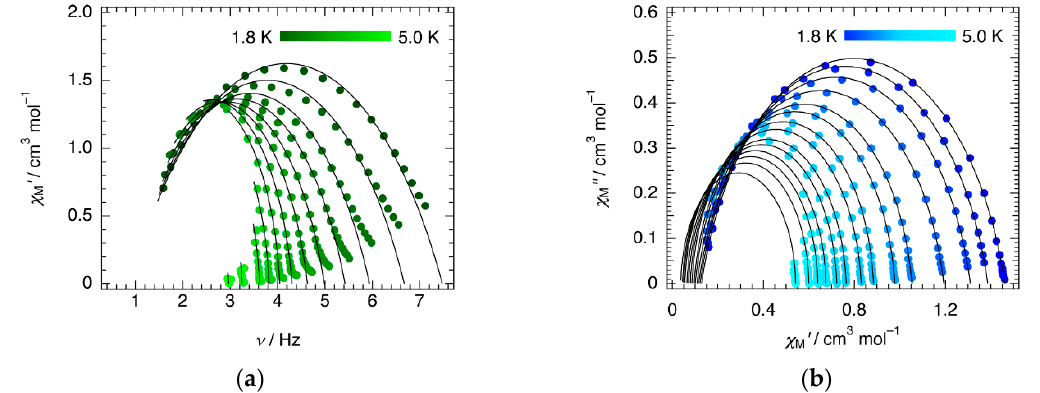
Figure 5. Argand plots for the molar ac susceptibility data of ( a ) 4 and ( b ) 5 in the temperature range 1.8–5.0 K under an applied dc field of 0.1 T. The solid black lines correspond to fits to the experimental data using the generalized Debye model with the α parameter in the ranges of 0.08–0.42 for 4 and of 0.02–0.18 for 5 .